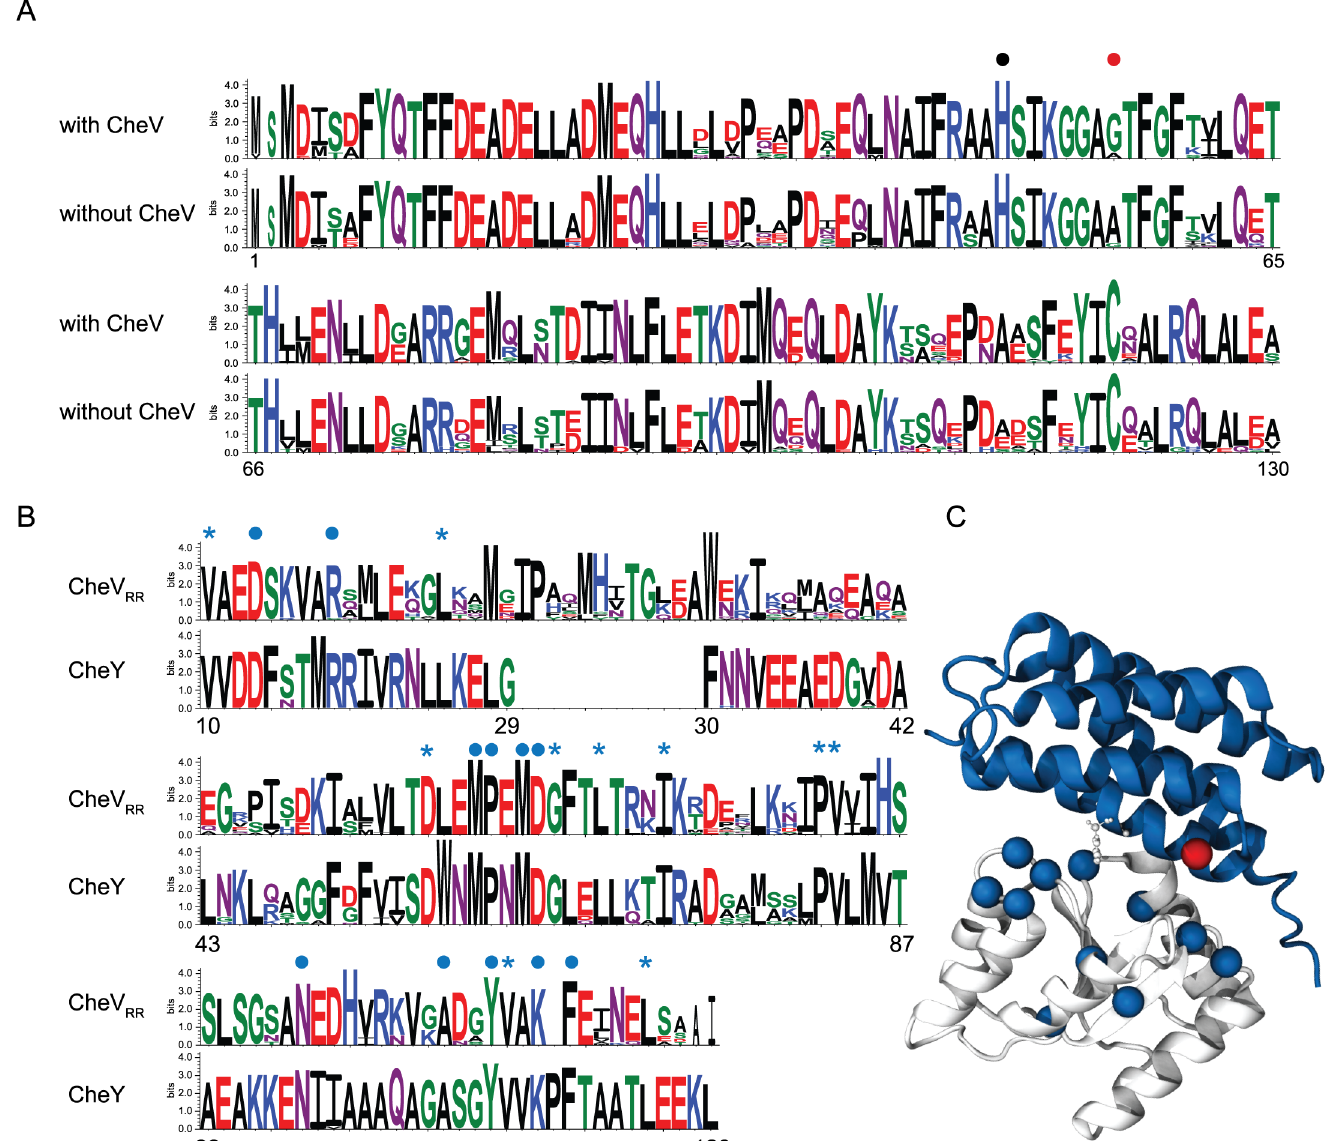
Fig 2. Analysis of patterns in sequence conservation suggests interaction between CheV RR domain and CheA-P1. A) Comparison between sequence logos of CheA P1 from genomes with and without CheV. The CheA P1 active site His48 (black dot) and the only different position between the two sets Gly55 (red dot) are marked. B) Comparison between sequence logos of CheY and the CheV RR domain. Positions that are conserved in both sets are marked (blue dots for solvent exposed positions (10 25 57 65 68 72 82 83 107 116) and blue stars for buried positions (13 18 60 61 63 64 94 103 106 109 111)). C) Cartoon representation of the CheY (white) and CheA P1 (blue) [35]. Solvent exposed positions conserved in CheY and CheV RR datasets localize to the protein interface region (blue spheres). The single position that is different between the sets of CheA P1 with and without CheV, Gly55 (red sphere), lays in the C-terminal part of the second α -helix involved in the interaction protein region that also contains the active site His48 (white CPK